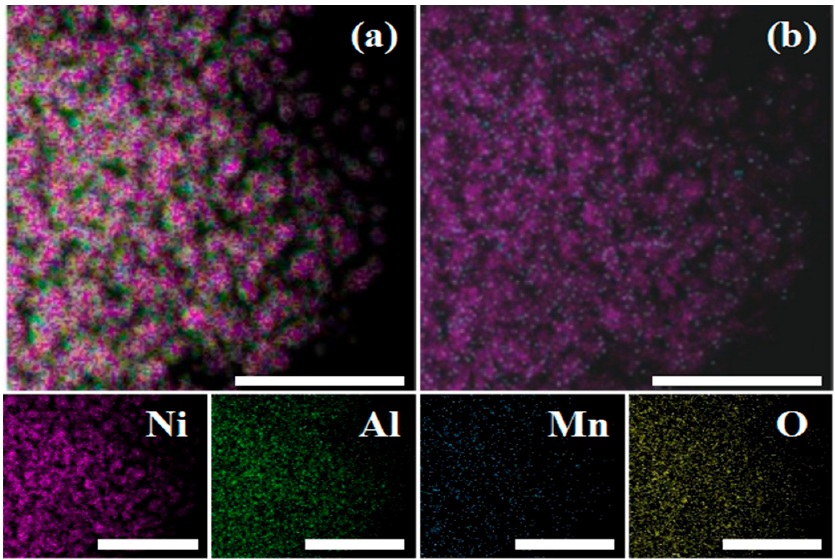
Figure 6. TEM-EDS mapping of the NiMn 1 Al 10 -C catalyst: ( a ) overlap of Ni, Al, Mn and O, ( b ) overlap of Ni and Mn. The scale bar is 20 nm.